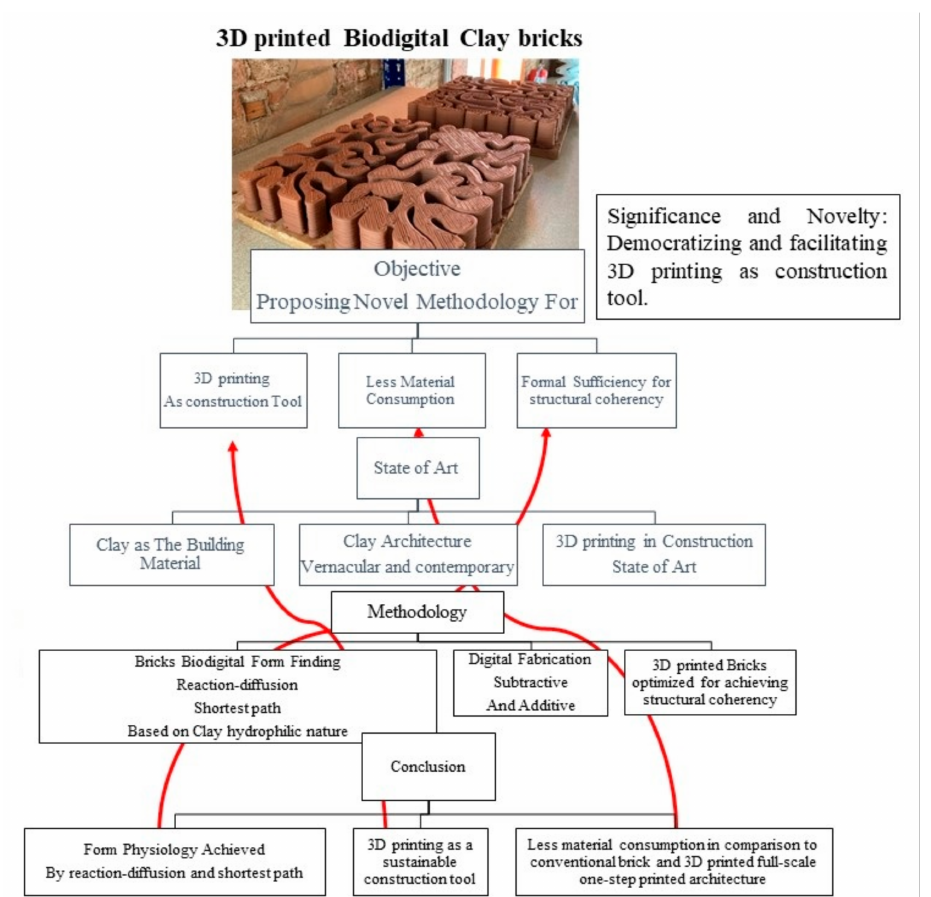
Figure 1. Diagram showing the objective and methodology of the 3D-printed Biodigital Barcelona Bricks. The diagram also shows the different sections of this paper’s structure and their relevance to the objective. (By the